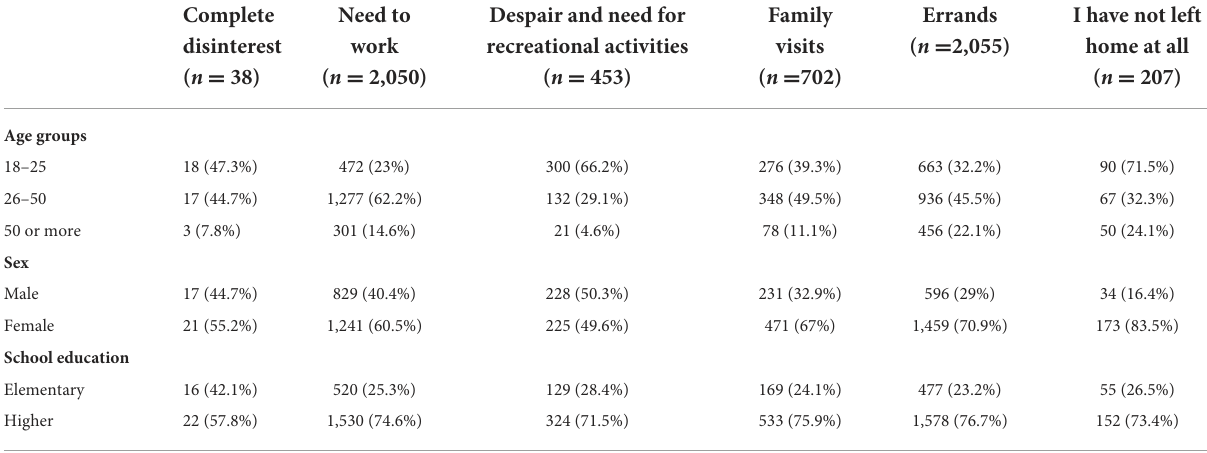
TABLE 2 Reasons why our sample broke social isolation